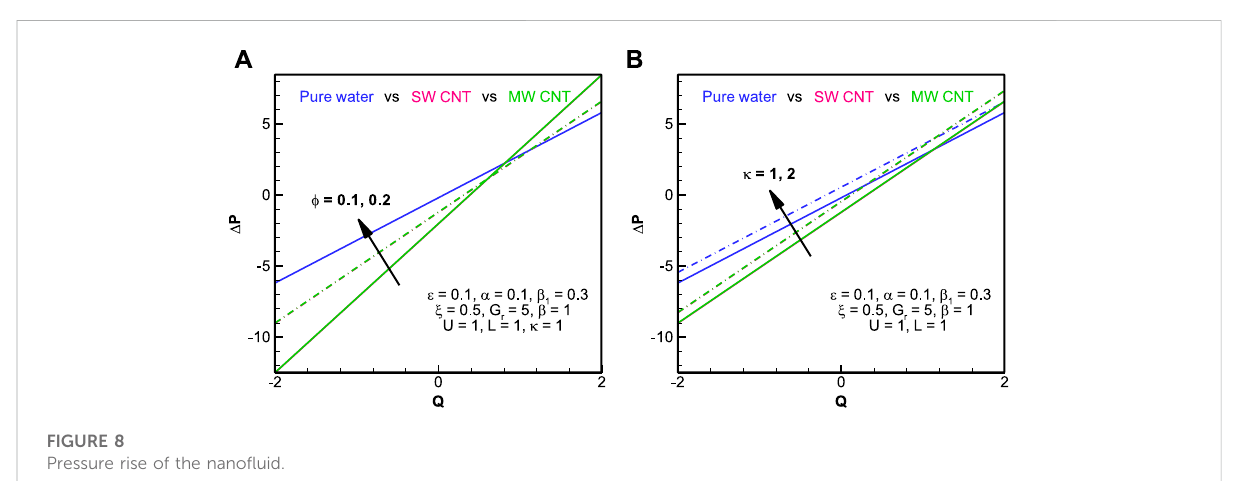
FIGURE 7 Pressure gradient of the nano fl uid.